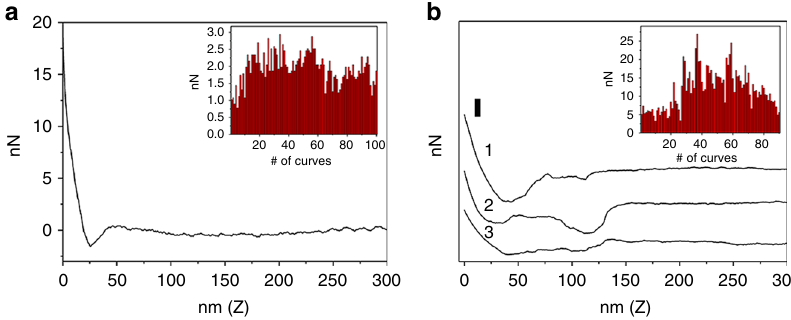
Fig. 5 AFM force spectroscopy. a A representative force curve plotted for the interaction between a bare SiO 2 spherical tip and a layer of copolymer 3 attached on a Si wafer. The adhesion force histogram for 100 force curves is given in the inset. b Representative force curves plotted for the interaction between a copolymer 3 functionalized SiO 2 tip and a layer of LPS attached on a Si wafer and collected before 90 ramp cycles (adhesion forces for curves 1, 2 and 3 are 17.07, 16.36 and 7.10 nN, respectively). The adhesion force histogram before 90 ramp cycles is given in the inset. Scale bar: 10 nN Fig. 4d indicates that tobramycin is not released by immobile bacteria and this is in agreement with our earlier fi ndings that when copolymer chains are not stripped off the particle surface, minimal leakage of payload occurs (see Fig. 3a). shell, the leakage of tobramycin into the surroundings prevented Despite the antimicrobial effects of YVLWKRKRKFCFI-NH 2 against P. mirabilis (MIC = 1.6 mg mL − 1 , Supplementary Fig. 8 Fig. 7 and Supplementary Note 4). Since differences in agar and Supplementary Note 5), Fig. 4a shows that the peptide from the I-DRS does not cause obvious damage to the swarmer colony;